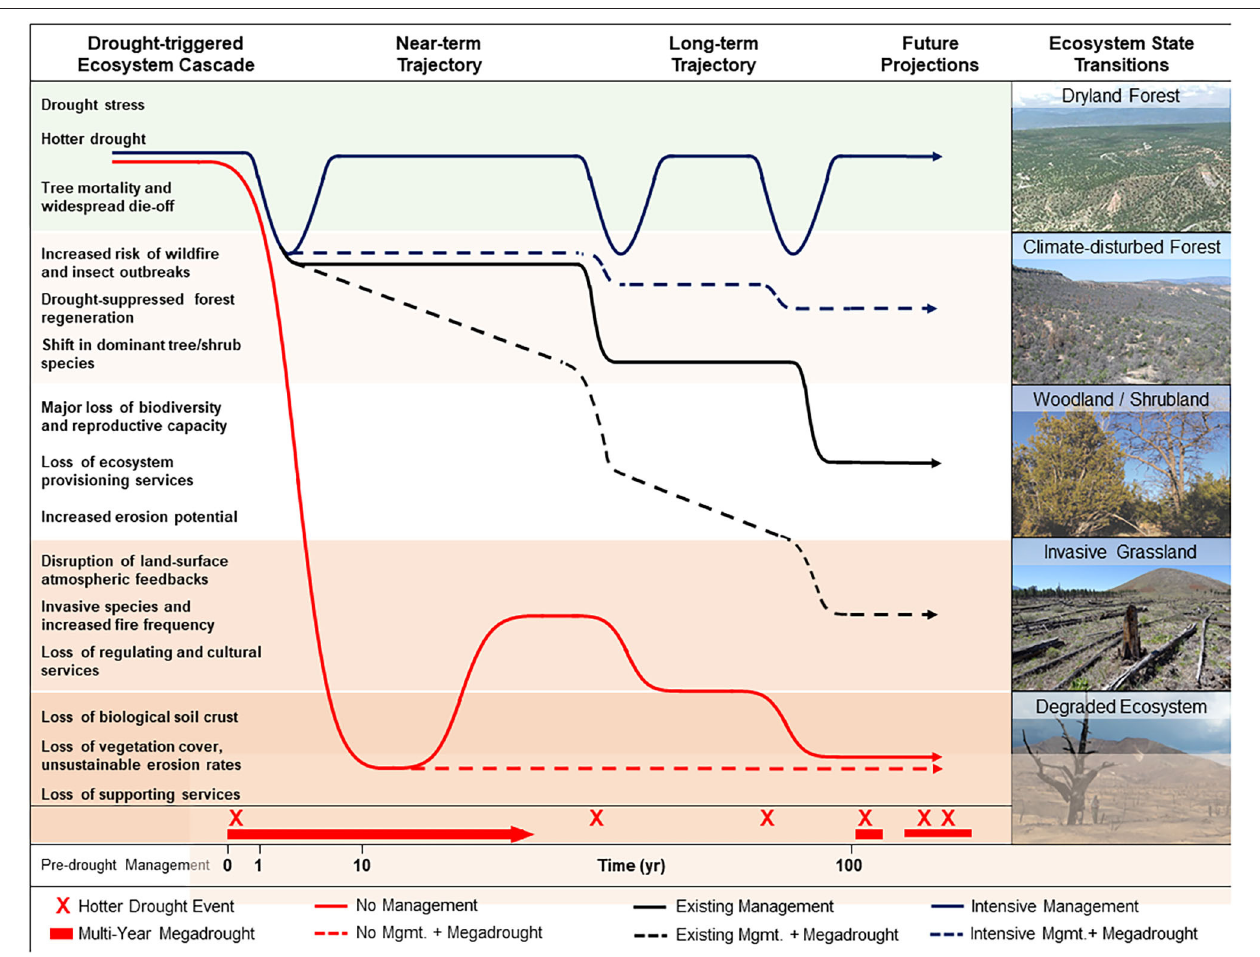
FIGURE 1 | Drought-triggered ecological cascade and management strategies at finer spatial scales to reduce the risk of forest die-off and ecosystem degradation, trajectories are theoretical examples highlighting possible outcomes for dry forests in the Western U.S. based on example references including but not limited to Allen et al. (2010, 2015), Breshears et al. (2011, 2018), Grant et al. (2013), Field et al. (2015), Bradford and Bell (2017), Cobb et al. (2017), and Petrie et al. (2017)—showing trajectories and future projections for unmanaged systems (red), systems managed with existing forest practices (black), intensively managed systems (blue)—for both recurring extreme drought (solid lines) and multidecadal megadrought (dashed lines); more mesic forests would experience different trajectories, particularly including species turnover toward more drought tolerant tree species while still remaining forest (e.g., Brando et al., 2019b). Photo credits: C. D. Allen, J. B.